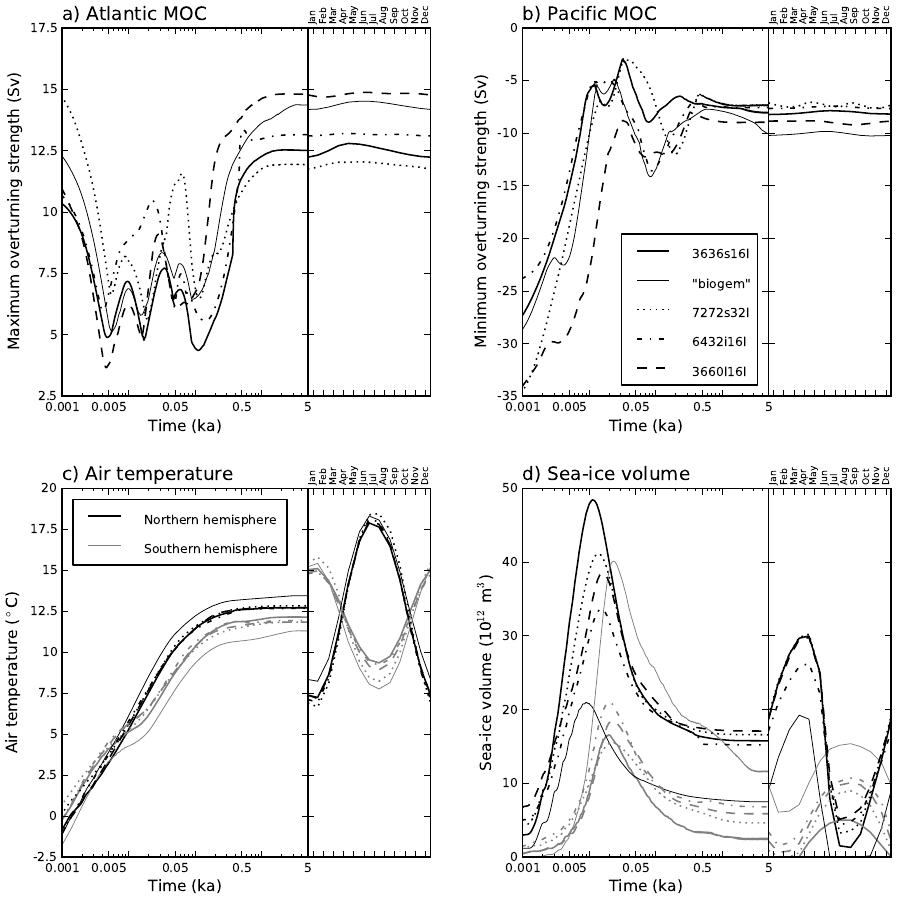
Fig. 6. Time series of the maximum of the sub-surface overturning rate in the Atlantic (a) , minimum of the sub-surface overturning rate in the Pacific (b) , hemispherically-averaged air temperature (c) , and hemispherically-integrated sea-ice volume (d) . For each spin-up, 1-yr running averages of the evolution of the diagnostic values are shown over 5000yr (left side of panels, note logarithmic time axes), alongside values at the beginning of each month for year 5000 (right side of